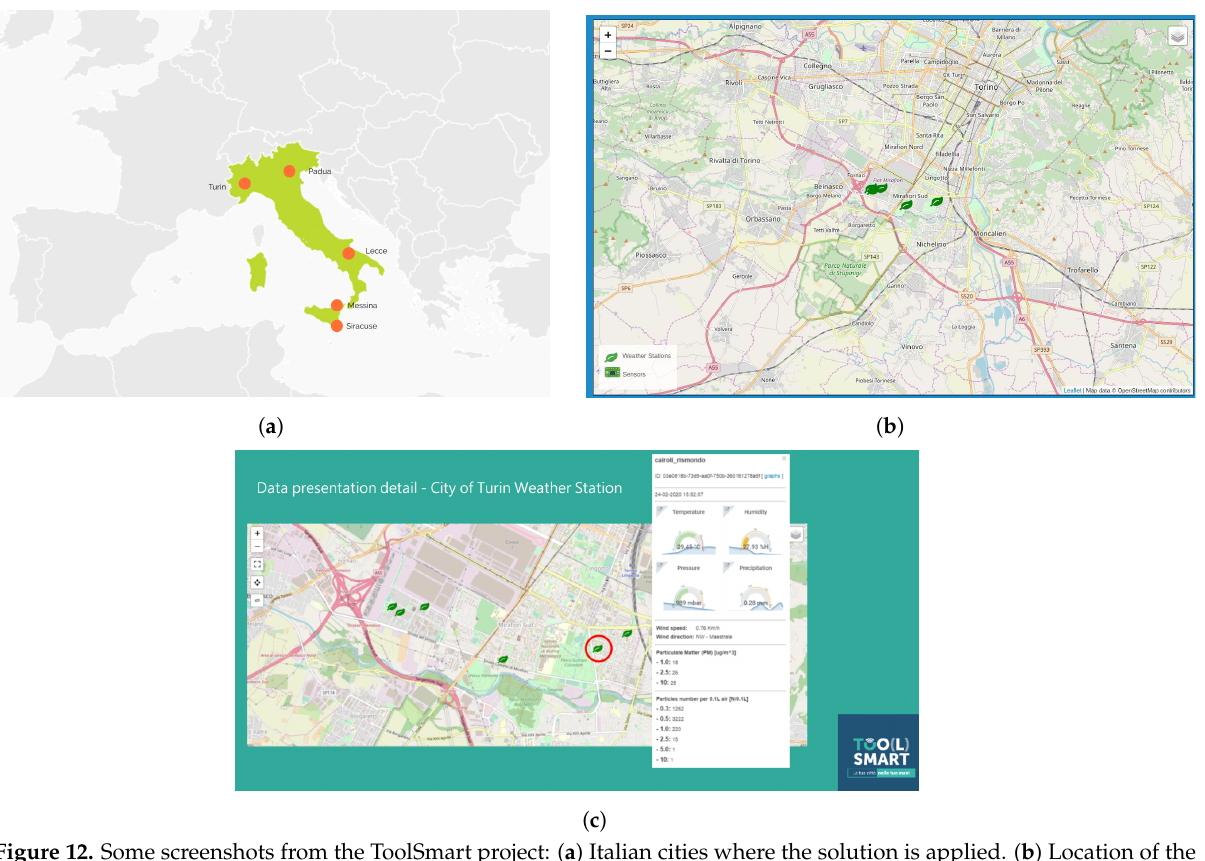
Figure 12. Some screenshots from the ToolSmart project: ( a ) Italian cities where the solution is applied. ( b ) Location of the Toolsmart IoT devices in Turin. ( c ) Interactive map exposed by the dataportal